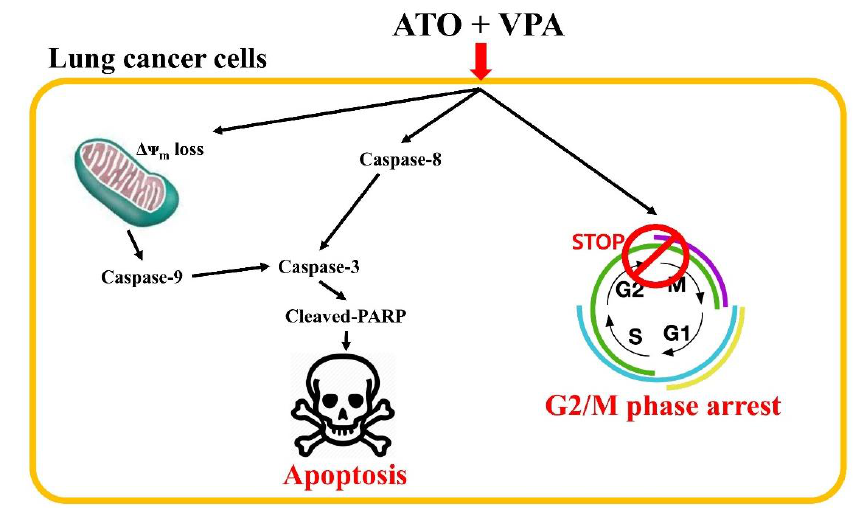
Figure 7. Schematic diagram of ATO / VPA-induced cell growth inhibition in lung cancer cells.